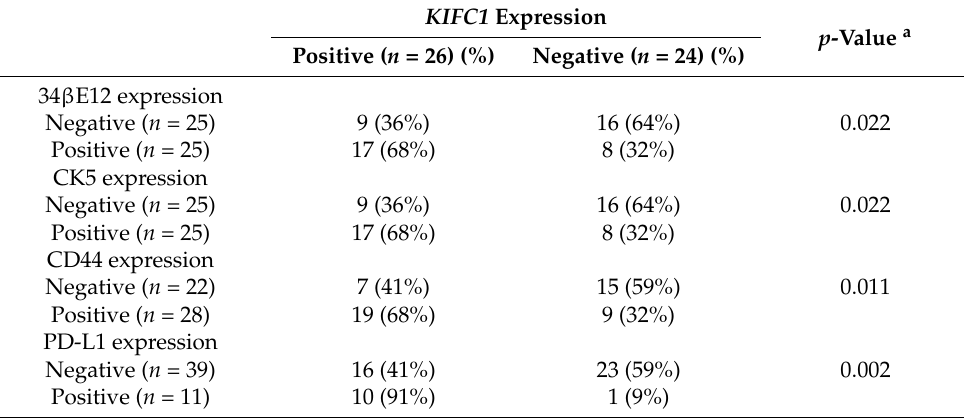
Table 3. Relationship between KIFC1 expression and 34 β E12, CK5, CD44 and PD-L1 in the 50 bladder cancer from Kure